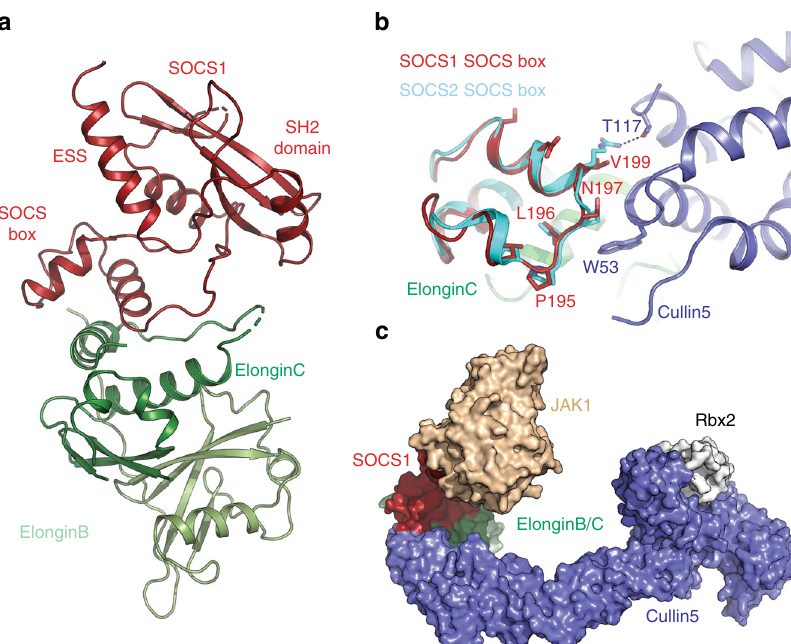
Fig. 4 Structure of the SOCS1 – Elongin B/C complex. a Structure of Xenopus laevis SOCS1 (red) in complex with Elongin B (pale green) and Elongin C (green). b The SOCS1 SOCS Box is shown overlaid with the structure of SOCS2 (cyan) bound to Cullin5 (blue). SOCS1 Asn197 takes the place of terminal proline typically seen in the canonical Cullin5 binding motif (LP φ P). This asparagine clashes with Trp53 of Cullin5. Likewise, the Arg186 (SOCS2)-Thr117 (Cul5) hydrogen bond is lost in SOCS1 which has a valine (Val200) in place of the arginine. c Model of the JAK1-SOCS1-Elongin B/C-Cullin5-Rbx2 (white) complex based upon the SOCS1/JAK1 (this manuscript), SOCS2/ElonginB/ElonginC/Cullin5 NTD (PDB: 4JGH) and Cul5 CTD/Rbx2 structures (PDB: 3DPL). The SOCS1/JAK1 interaction orients JAK1 toward rbx2, which is the site of activated-ubiquitin (ubiquitin-E2)